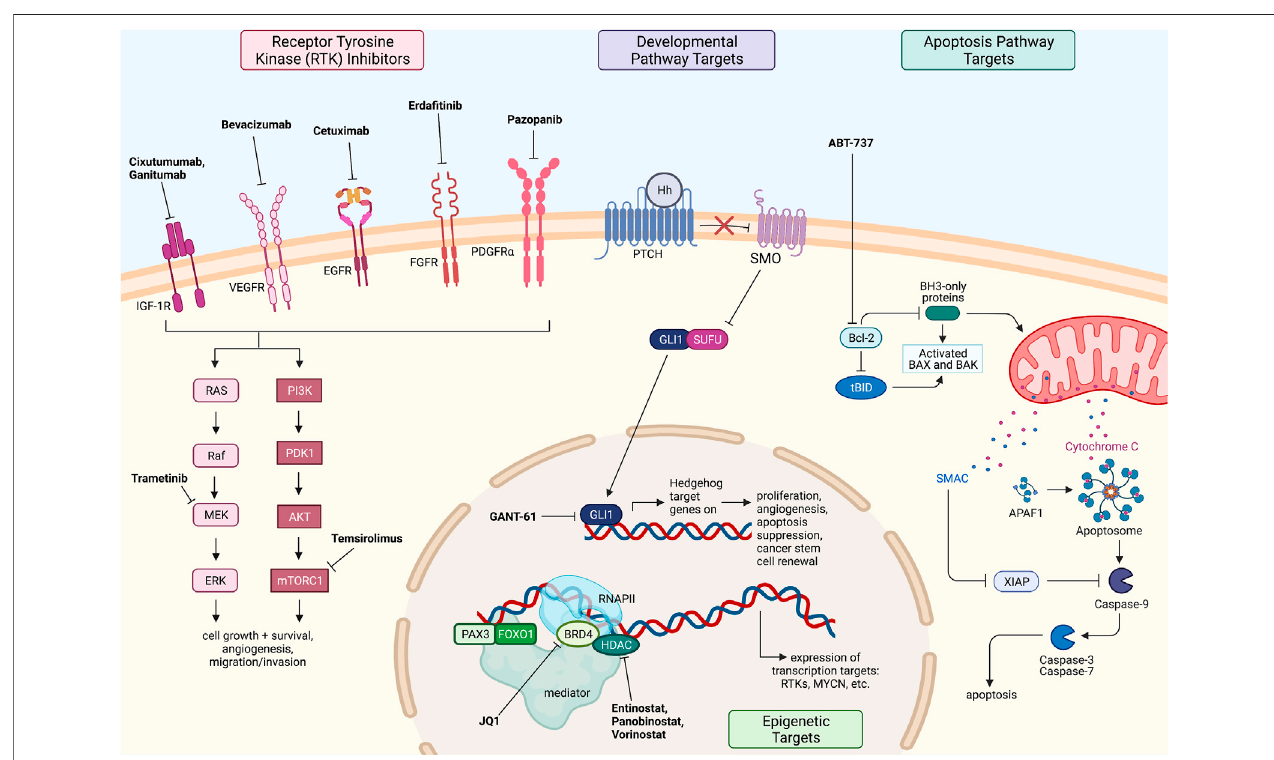
FIGURE2| Fusiondrivenpediatricsolidtumorswithclinicallyactionabletargets.Rhabdomyosarcomatherapeutictargetsanddrugsunderinvestigation.All fi gures were created with BioRender.com.